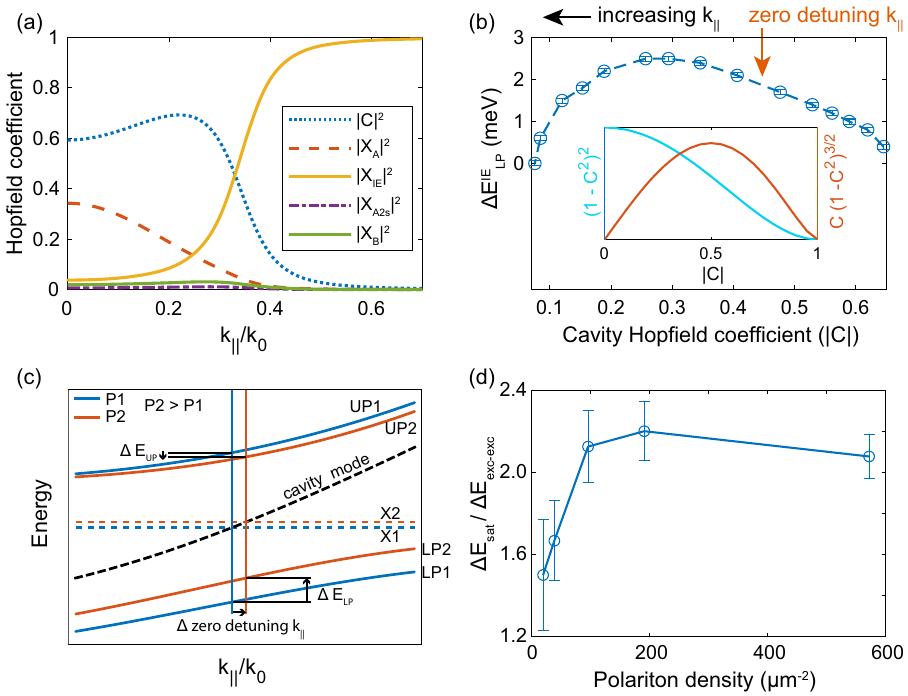
Fig. 4 | Nonlinear responseofthe IEpolariton. a The Hop fi eld coef fi cients of the lowerIEpolaritonshowingthecontributionsofcavityphotonandthefourexcitons asa function of k ∥ . b Experimentally measured blueshift of the IElowerbranchas a function of k ∥ at a polariton density~95 μ m − 2 . Here k ∥ is converted to cavity Hop- fi eld coef fi cient using the previous plot. The blueshift of the lower branch of IE ( Δ E IE LP ) is highest close to the zero-detuning k ∥ , but the shape looks like a tilted parabola. This can be explained by taking both exciton-exciton interaction and saturation effect into account. Inset shows the theoretically expected dependence of exciton-exciton interaction and saturation effect on ∣ C ∣ . It can be seen that superimposition of these two graphs can explain the tilted parabola shape of Δ E IE LP